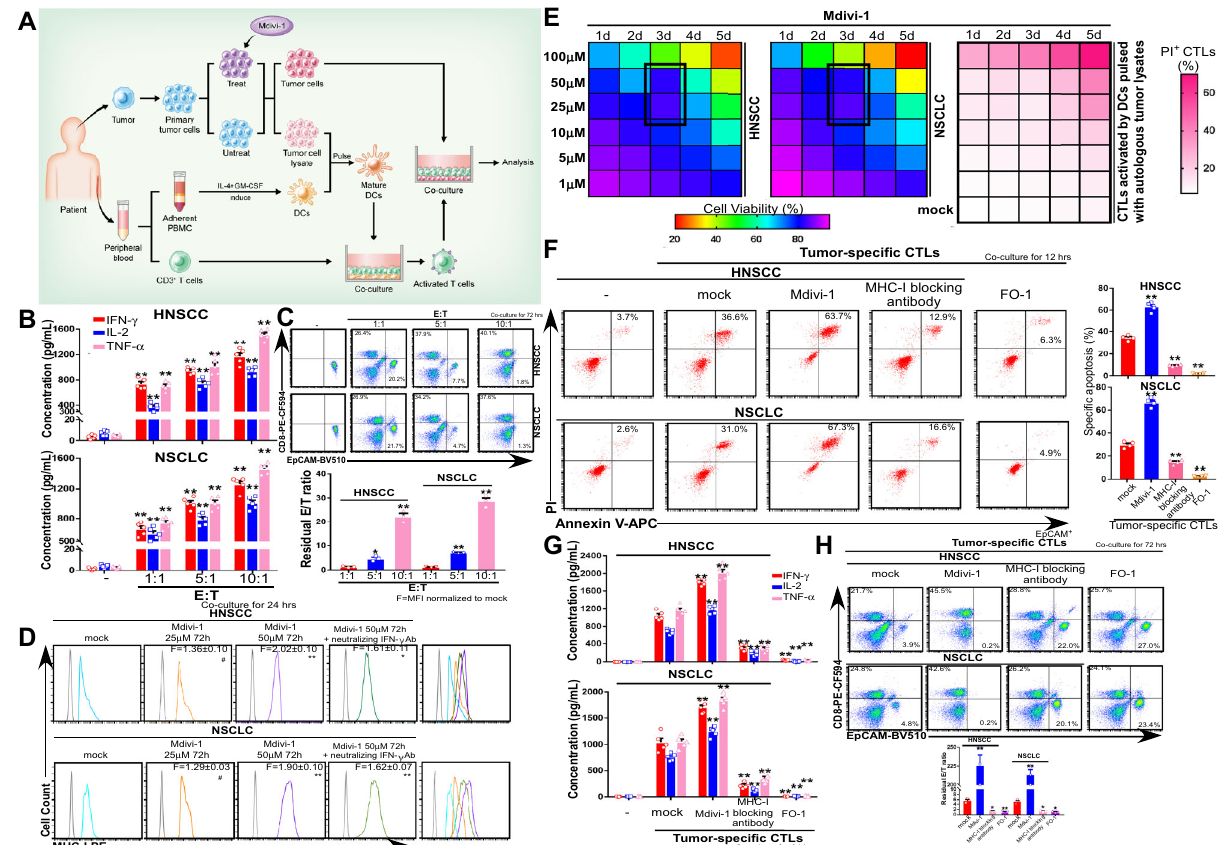
Fig. 4 Mdivi-1 improves the cytotoxic function of CTLs targeting autologous cancer cells in vitro. A Scheme of tumor-speci fi c CTLs generation and in vitro coculture. B Twenty hours later, Th1 cytokines production was quanti fi ed by speci fi c ELISAs (mean ± s.e.m; n = 5; p < 0.0001 for HNSCC and NSCLC; ** p < 0.001 compared with non-coculture group by two-tailed t -test). C Residual E/T ratio was evaluated by fl ow cytometry after 3 days based on CD8 and EpCAM expression (mean ± s.e.m; n = 3; p = 0.0015 or p < 0.0001 for HNSCC and p < 0.0001, p < 0.0001 for NSCLC; * p < 0.01, ** p < 0.001 compared with E/T ration = 1:1 group by two-tailed t -test). D Evaluation of MHC-I membrane expression in HNSCC and NSCLC primary cancer cells by fl ow cytometry. F indicates the fold change of MFI normalized to mock (mean ± s.e.m; n = 12; p = 0.0484, 0.0001, 0.0005 for HNSCC and 0.0487, 0.0001, 0.0001 for NSCLC # p < 0.05, * p < 0.01, ** p < 0.001 compared with mock by two-tailed t -test). E Cell viability of primary cancer cells and PI uptake of tumor-speci fi c CTLs after sequential treatment by MTS and fl ow cytometry. F Twelve hours after coculture, EpCAM + cancer cells were harvested and cell death was examined with fl ow cytometry based on the uptake of PI and Annexin V. E/T ratio was 5:1 (mean ± s.e.m; n = 4; p < 0.0001 for HNSCC and p < 0.0001 for NSCLC; ** p < 0.001 compared with mock by two-tailed t -test). G Th1 cytokines production was quanti fi ed by speci fi c ELISAs after 24 h. E/T ratio was 5:1 (mean ± s.e.m; n = 5; p < 0.0001 for HNSCC and NSCLC; ** p < 0.001 compared with mock by two-tailed t -test). H Evaluation of residual E/T ratio by fl ow cytometry based on CD8 and EpCAM expression respectively following 3 days. E/T ratio was 5:1 (mean ± s.e.m; n = 3; p < 0.0001, p = 0.0011, 0.0009 for HNSCC and p < 0.0001, p = 0.0015, 0.0012 for NSCLC; * p < 0.01, ** p < 0.001 compared with mock by two-tailed t -test). E indicates effector cells, namely T cells. T indicates targeted cells, namely cancer cells. XBP-1s alone signi fi cantly downregulated MHC-I expression, co- IRE1 α , the most conserved arm of the UPR 3 , is the most sig- transfection of XBP-1s and DN IRE1 α had no impact on MHC-I ni fi cant regulator of MHC-I expression by TSCC cells (Supple- expression, as expected (Fig. 5F). Despite inducing changes in the mentary Fig. 6A). Within minutes of unfolded protein expression of MHC-I and ER stress markers GRP78, CHOP 34 , accumulation, BiP dissociates from PERK, IRE1 α , and ATF6 and preferentially binds to the unfolded proteins, resulting in the and XBP-1s (Fig. 5E and Supplementary Fig. 6C – F), HLA-A/B/C activation of PERK and IRE1 α via luminal domain homo- and B2M protein and mRNA expression levels were not sig- dimerization and autophosphorylation of ATF6 via proteolytic ni fi cantly altered upon DN IRE1 α transfection, XBP-1s knock- cleavage 9 . Active IRE1 α then excises a 26-base intron in X-box down, or XBP-1s transfection (Supplementary Fig. 6G – I). The binding protein 1 (XBP-1) mRNA. Re-ligation of spliced XBP-1 results we obtained with TSCC cell lines following DRP-1 shifts the open reading frame, and its translation produces the knockdown and DRP-1 overexpression were consistent (Fig. 5G). homeostatic transcription factor spliced XBP-1 (XBP-1s). XBP-1s translocates to the nucleus where it binds to UPR elements (UPRE) and activates UPR target genes. On the other hand, TPP2 is a direct target of XBP-1s . Many potential mechanisms unspliced XBP-1 (XBP-1u) gets degraded rapidly 33 . Knockdown have been proposed regarding the regulation of MHC-I cell of XBP-1s by siRNA (GenePharma) signi fi cantly upregulates surface expression by ER stress signaling, including (i) removal or MHC-I expression to a similar level as TSCC cells transfected reduced synthesis of some unfolded proteins, possibly MHC-I with DN IRE1 α (Supplementary Fig. 6B). While transfection of subunits, to enable folding of essential or misfolded proteins 35 , NATURE COMMUNICATIONS| (2022) 13:3882